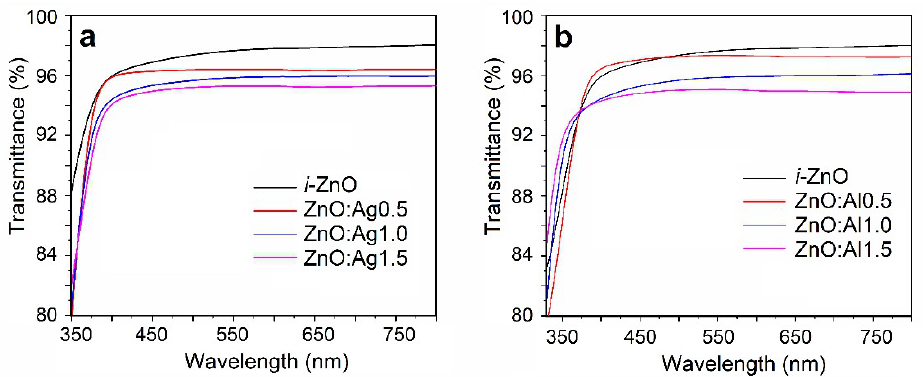
Figure 5. Effect of dopant type and concentration on the optical transmission spectra of the ZnO films: ( a ) Ag-doped ZnO films (ZnO:Ag) and ( b ) Al-doped ZnO films (ZnO:Al).